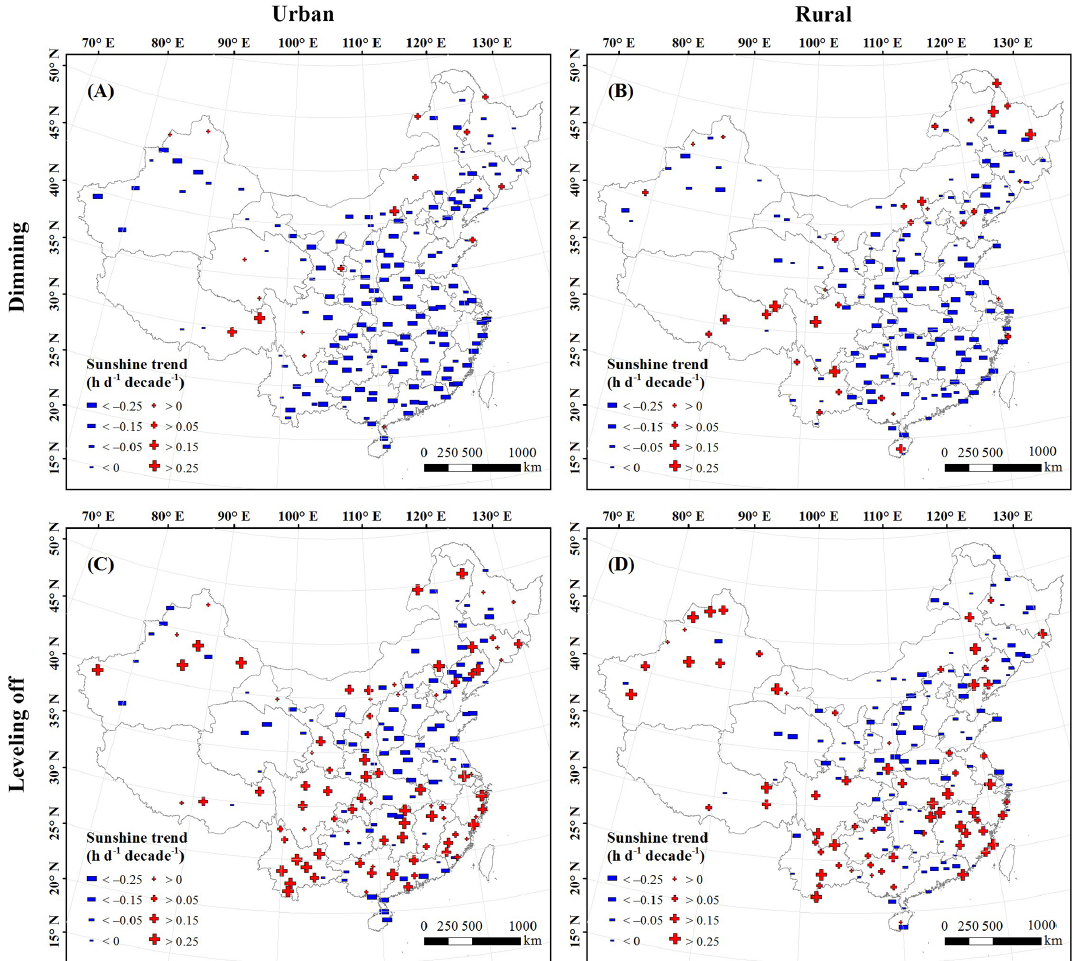
Figure 2. Spatial comparisons of sunshine duration trends (hd − 1 decade − 1 ) between urban and rural stations for the dimming (1960–1989) and leveling-off (1990–2013) phases. (a) Urban trends in the dimming phase, (b) rural trends in the dimming phase, (c) urban trends in the leveling-off phase, (d) and rural trends in the leveling-off phase. The blue minus signs indicate decreasing trends in sunshine duration, while the red plus signs indicate increasing trends in sunshine duration. The bigger the signs, the more significant the magnitudes of the changes.